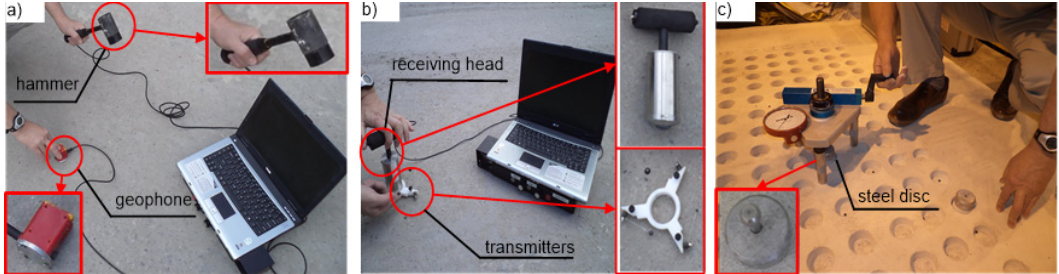
Figure 2. Exemplary view of tests carried out on the surface of the overlay using: ( a ) the IR method; ( b ) the I ‐ E method; and ( c ) the pull ‐ off method.